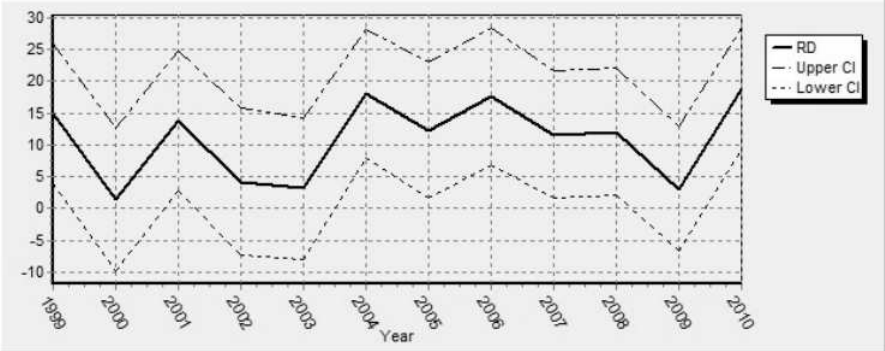
Figure 3. Trends of rate difference of age-standardised mortality rates among men in Świętokrzyskie, years 1999-2010